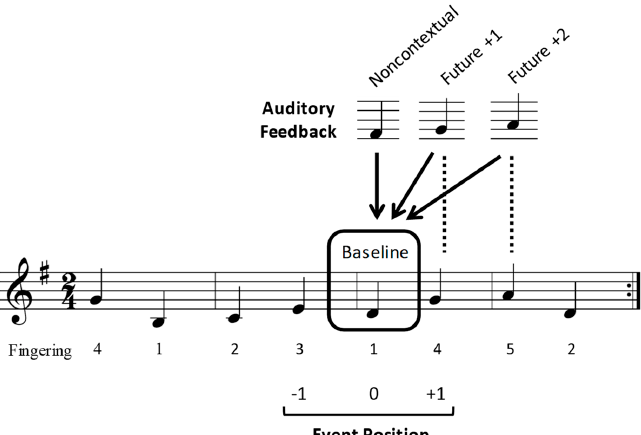
Figure 1. Example of a notated stimulus melody. Sample altered feedback pitches for the four auditory feedback conditions (baseline, noncontextual, future +1, and future +2), and the three target event positions ( − 1, 0, +1) over which interonset intervals (IOIs) and event-related potentials (ERPs) were analyzed are shown. Target event positions are numbered with respect to the distance of the altered feedback from its intended sequence position. Arrows show the location at which the altered feedback pitches occurred, and dashed lines indicate the origin of the altered feedback pitches.